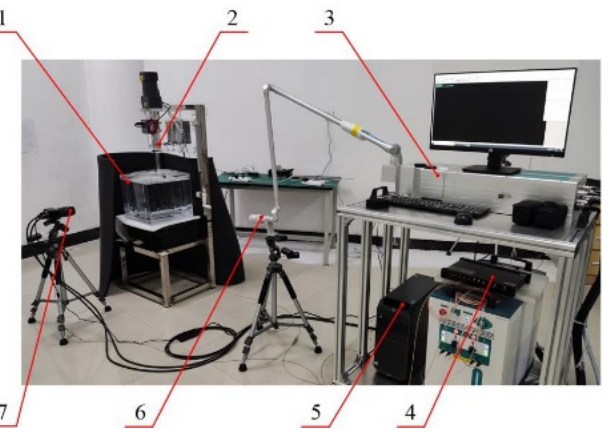
Figure 3. PIV measurement system. 1—stirred tank, 2—electromagnetic phase locking device, 3— laser, 4—synchronizer, 5—computer, 6—cylindrical lens, 7—CCD camera.